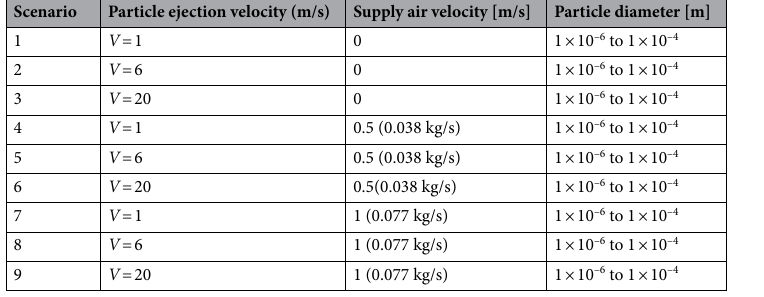
Table 1. Simulation scenario.